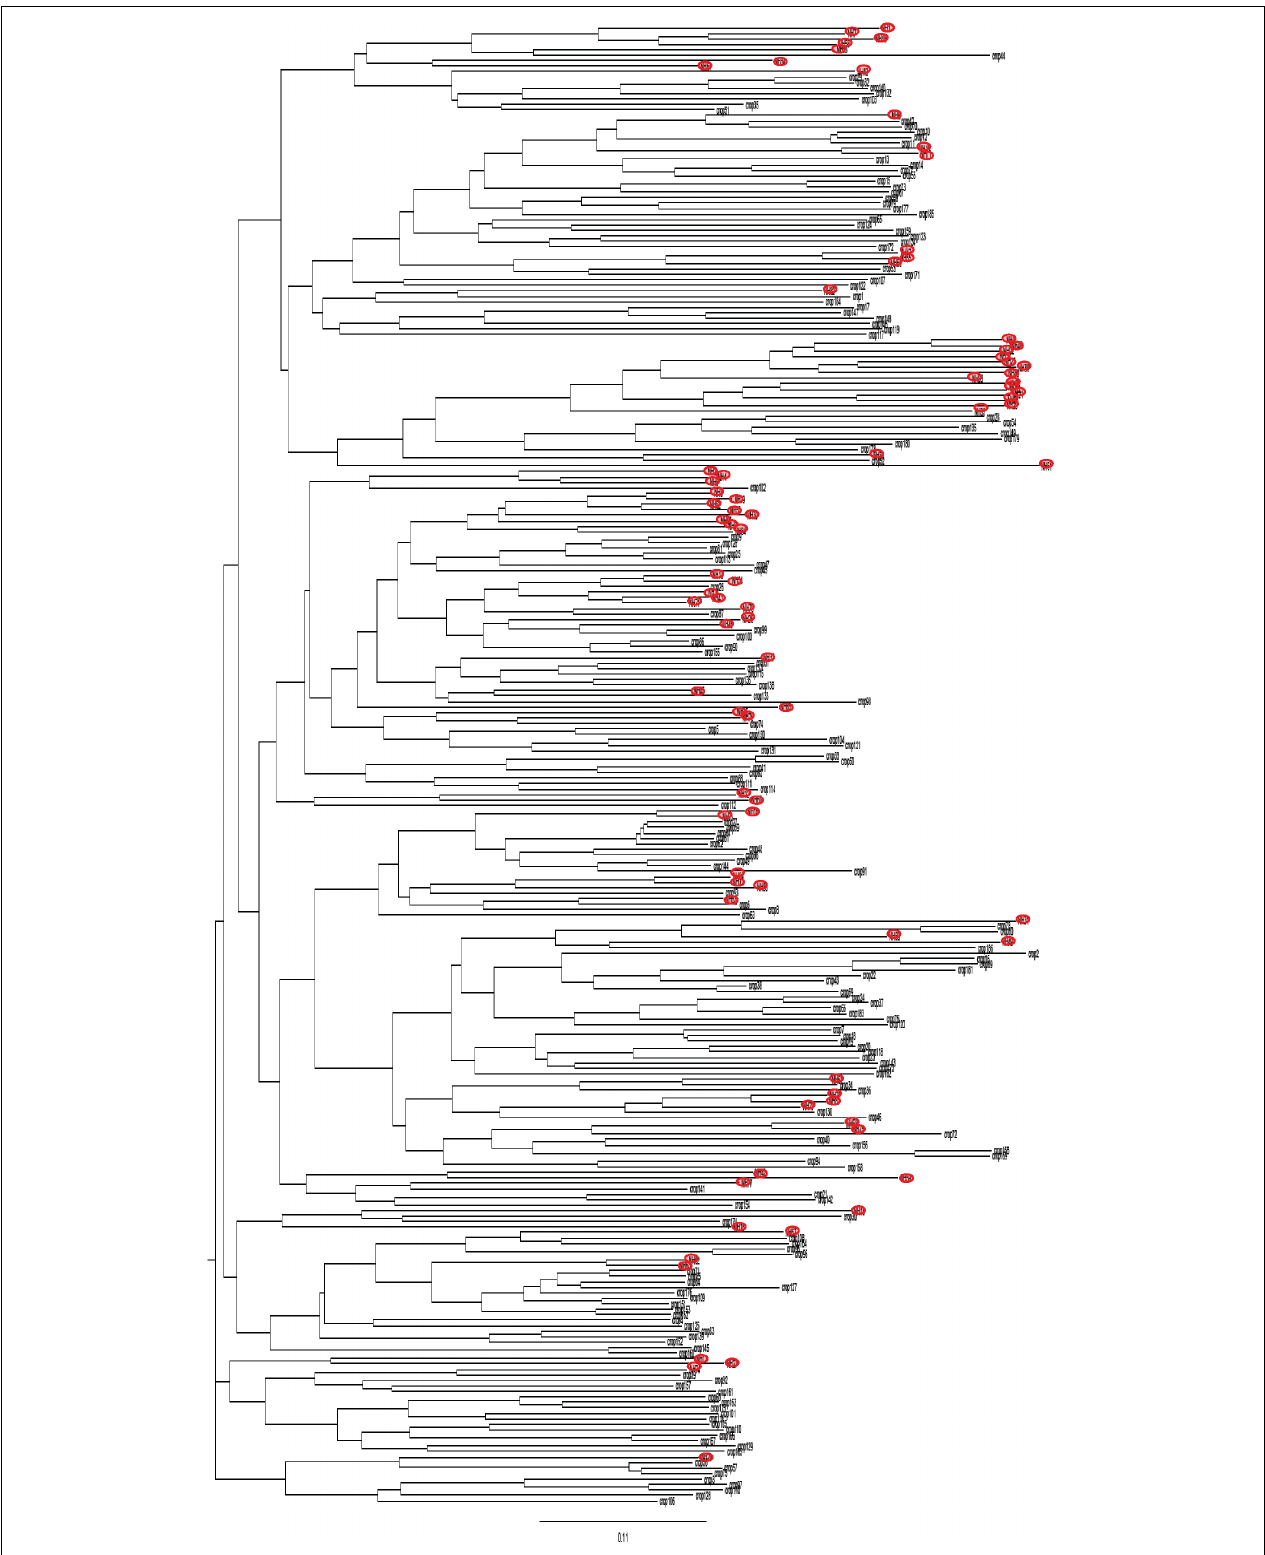
FIGURE 1 | Neighbor-joining tree showing the genetic distance between strains from non-agricultural habitats (red circle) and from crops, based on microsatellite markers.